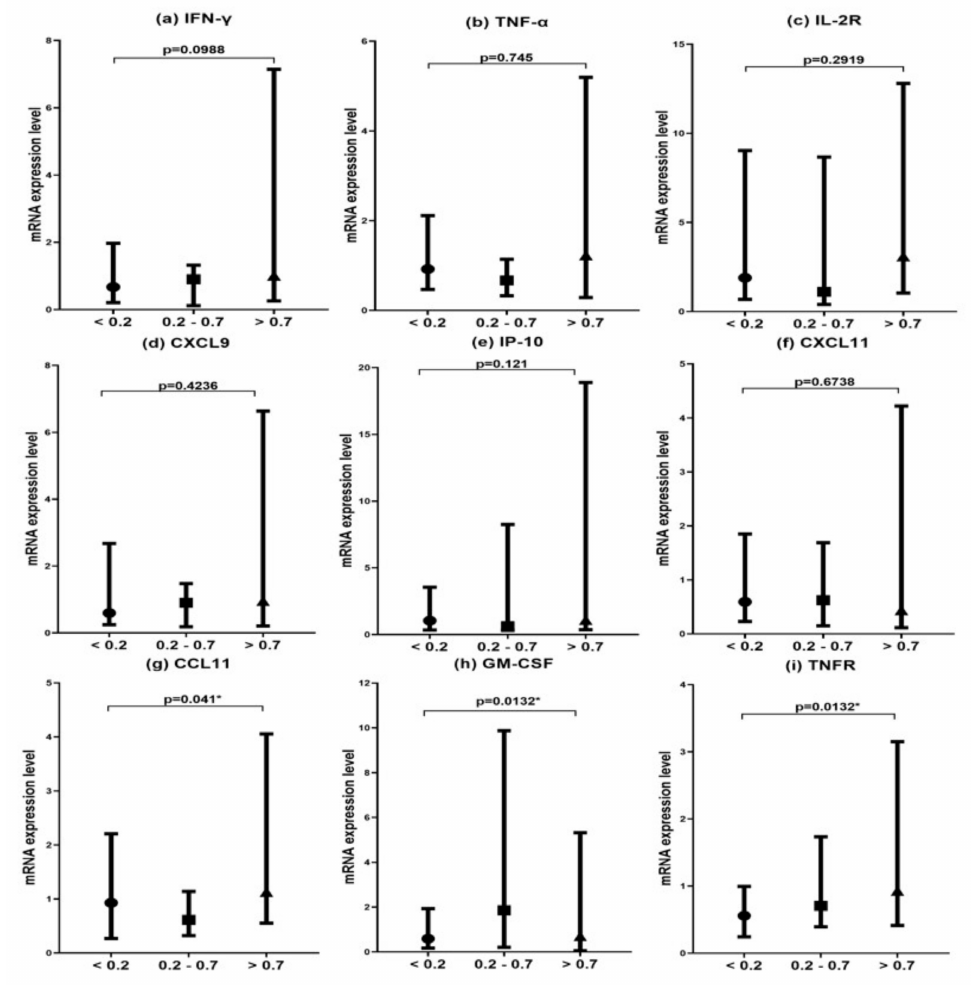
Figure 3. Target gene mRNA expression levels after stimulation of Mycobacterium tuberculosis (MTB)-specific antigens for 24 h according to QuantiFERON-TB Gold In-Tube (QFT-GIT) response groups in hemodialyzed patients (HD). Note: Whole blood of study subjects (the <0.2 IU/mL QFT-GIT response group, 0.2–0.7 IU/mL QFT-GIT response group, and >0.7 IU/mL QFT-IT response group) in HD was stimulated with MTB-specific antigens (early secretory antigen target 6, culture filtrate protein 10, and TB 7.7) for 24 h, and the mRNA expression levels for target genes were analyzed using real-time RT-PCR. The graphs represented median ± SD value ( (cid:4) , HD/normal; • , HD/LTBI; (cid:78) , HC). ( a ) interferon (IFN)- γ , ( b ) tumor necrosis factor- α (TNF- α ), ( c ) IL-2R, ( d ) CXCL9, ( e ) IFN- γ -induced protein 10 (IP-10), ( f ) CXCL11, ( g ) CCL11, ( h ) granulocyte-macrophage-colony stimulating factor (GM-CSF), and ( i ) TNF receptor (TNFR). * p <